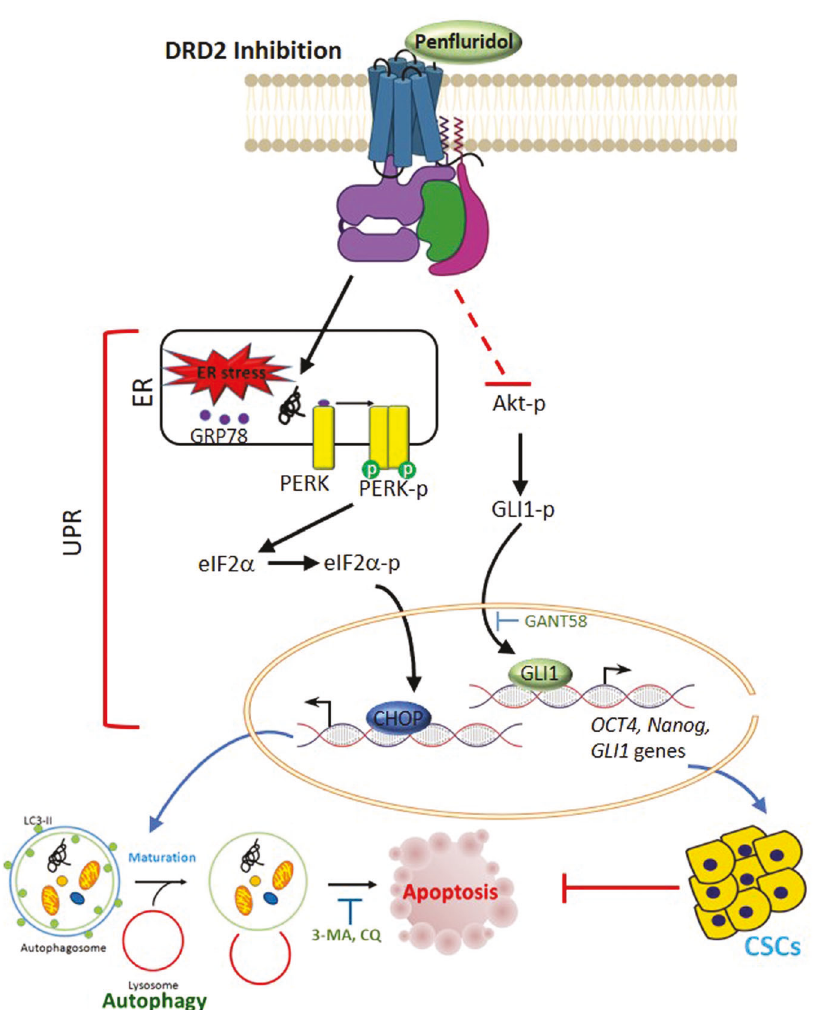
Fig. 8 A working model shows the molecular mechanism underlying the ability of the dopamine receptor D2 (DRD2) antagonist pen fl uridol to retard growth of clear cell renal cell carcinoma (ccRCC) cells. The anticancer activity of pen fl uridol on ccRCC cells was attributed to induction of ER stress leading to UPR-mediated autophagy and subsequently induction of apoptosis. Meanwhile, pen fl uridol not only triggers apoptosis but also attenuates stemness of ccRCC cells via inhibiting Akt/GLI1/OCT4/Nanog axis. Bold dashed lines indicate hypothetical pathways which might be inhibited by pen fl activity by reducing leukemic stem cell function in forming be cell-type dependent. Indeed, we also observed that DRD2 leukemia [39]. In our present study, results from sphere-formation expression was positively and negatively correlated with PRKACA and xenotransplantation limiting dilution assays also showed that (PKA catalytic subunit) and EGFR expression in patients with ccRCC pen fl uridol exhibits in vitro and in vivo anti-CSC activities in ccRCC. from TCGA database (Supplementary Fig. 11). The roles of cAMP/ PKA and EGFR in the anticancer effects of pen fl uridol for ccRCC need to be further investigated in the future. Recently, DRD2 was found in CSCs. For example, treatment with increased resistance to TKIs, higher sphere-forming ability, and the DRD2 antagonist, thioridazine, revealed in vivo anti-CSC tumor growth-inducing potential in vivo, and expressed high